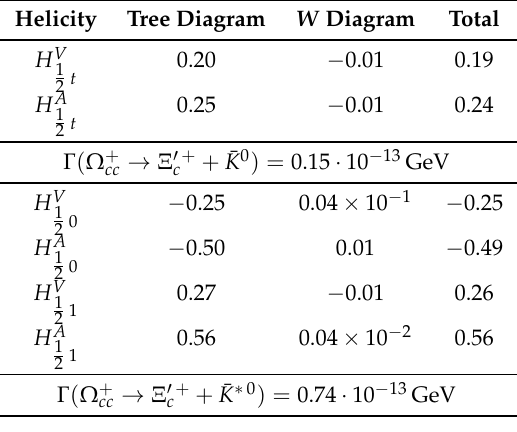
Table 4. Decays Ω + cc → Ξ (cid:48) + c + ¯ K 0 ( ¯ K ∗ 0 ) .